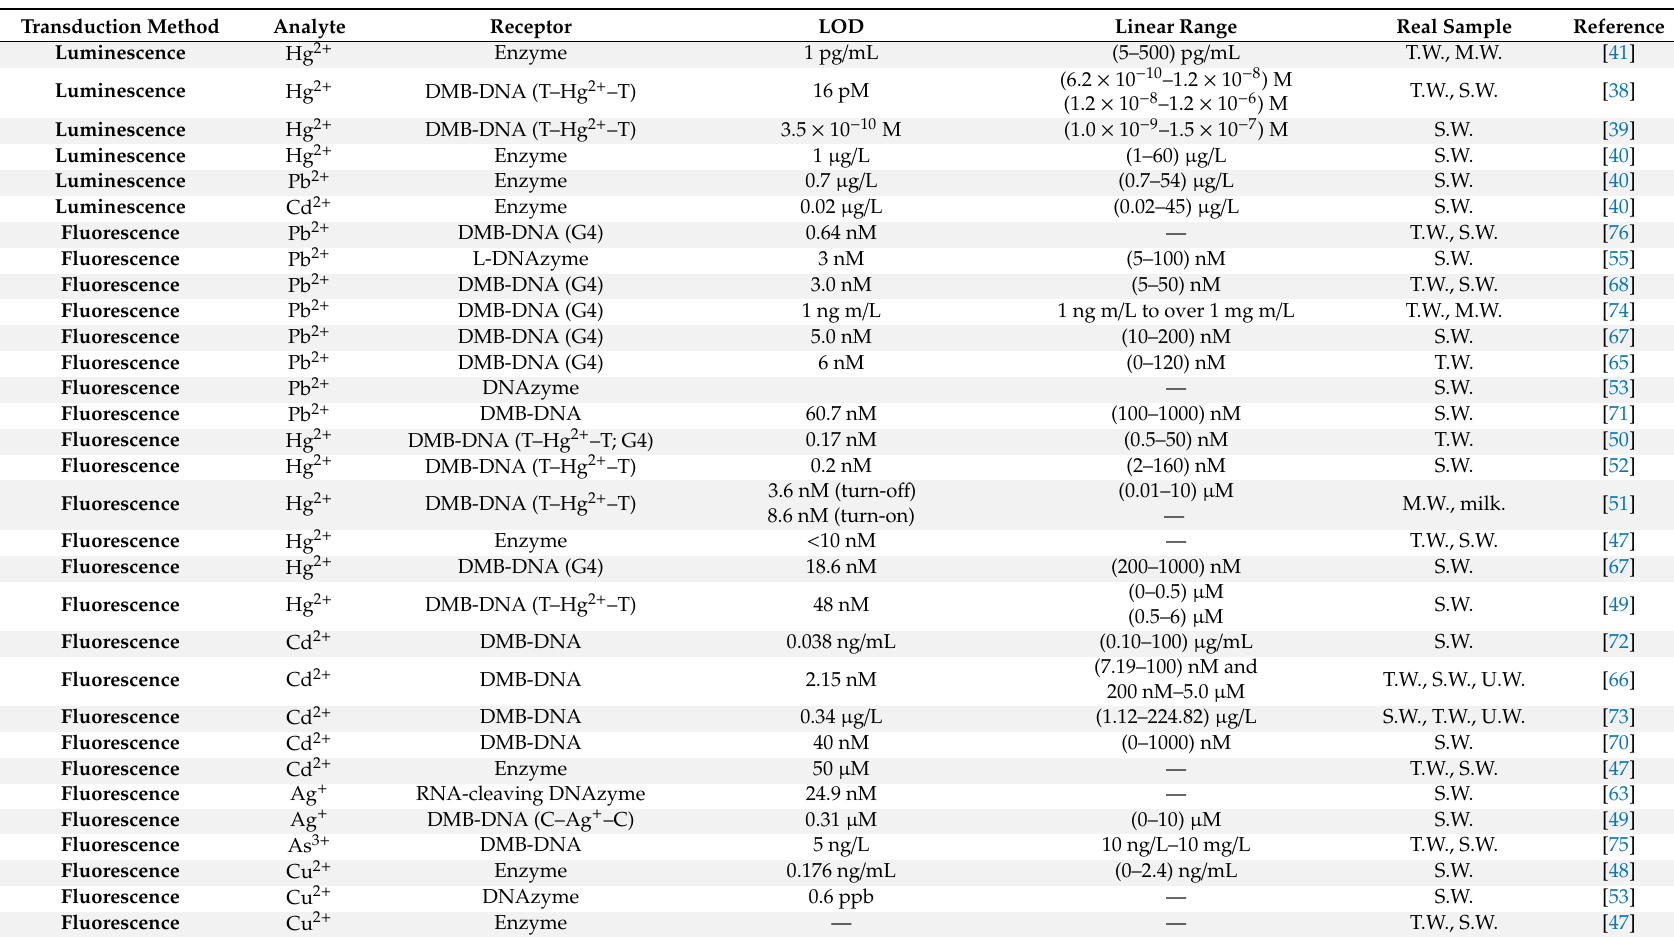
Table 1. Recently reported biosensors sorted in function of the lower limit of detection (LOD), with respect to a specific analyte within the specific transduction method. Cited literature refers to analytic procedures performed on real